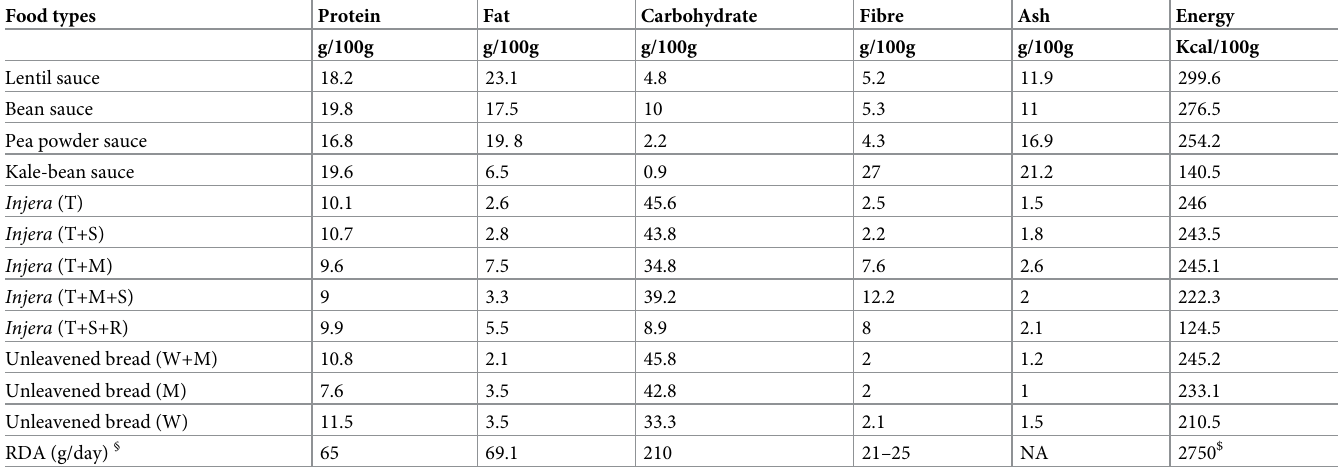
Table 6. The proximate and energy composition (dry weight basis) of sampled maternal foods in three districts of Jimma Zone, Southwest Ethiopia from March- May 2014. Food types Protein